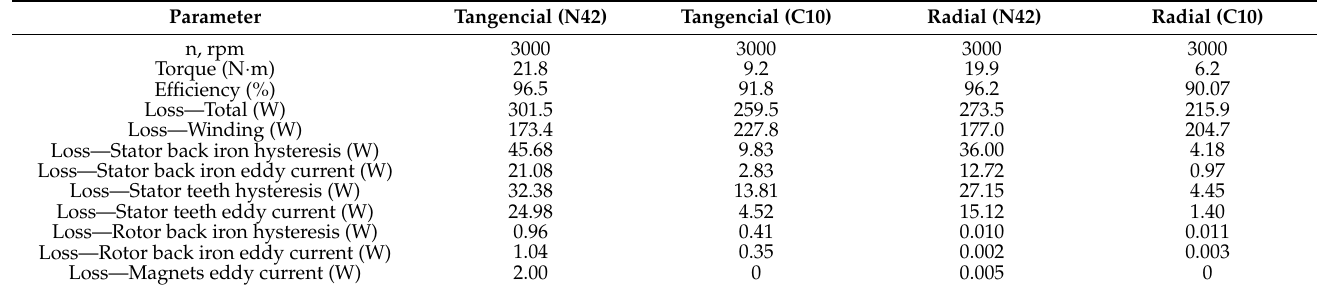
Table 2. Power loss in the tangential and radial machines with N = 10 turns.